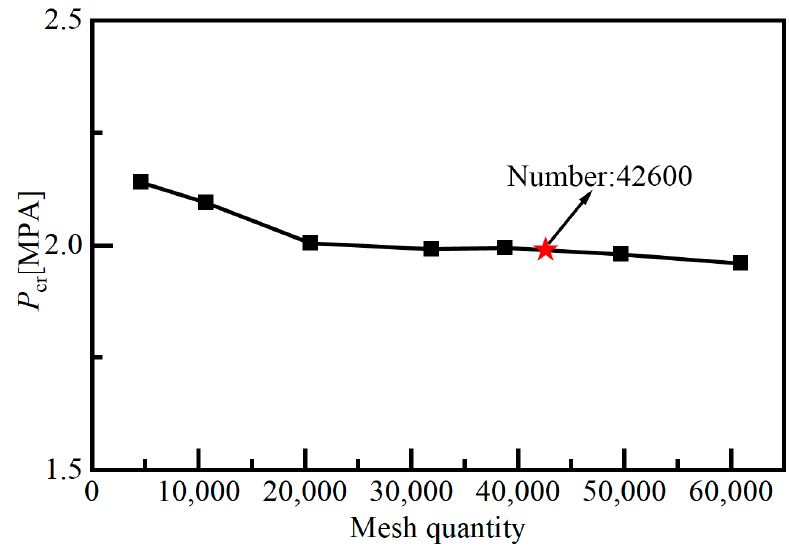
Figure 16. Convergence study of the bi-segment bugled hulls.